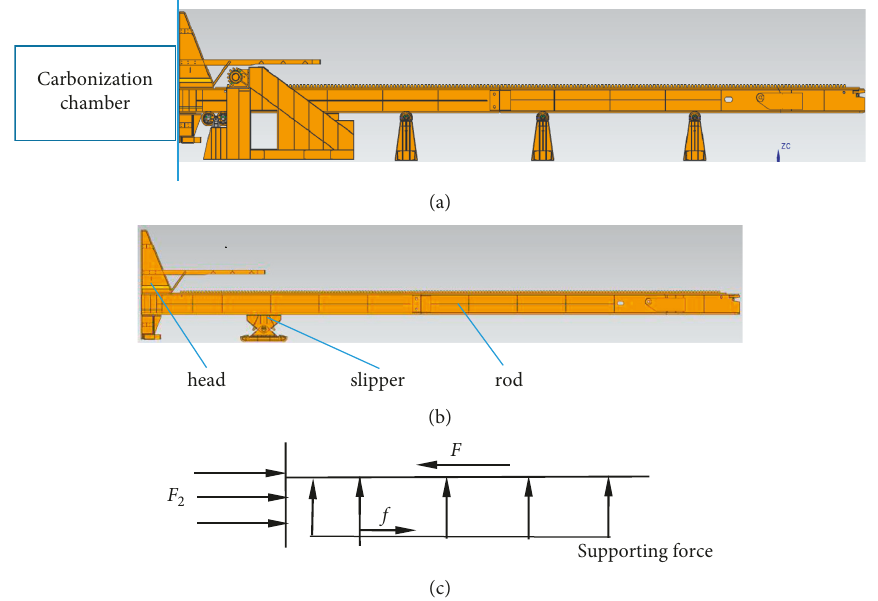
Figure 1: Structure of coke pusher. (a) Coke pushing device. (b) Coke pusher. (c) Stress analysis of coke